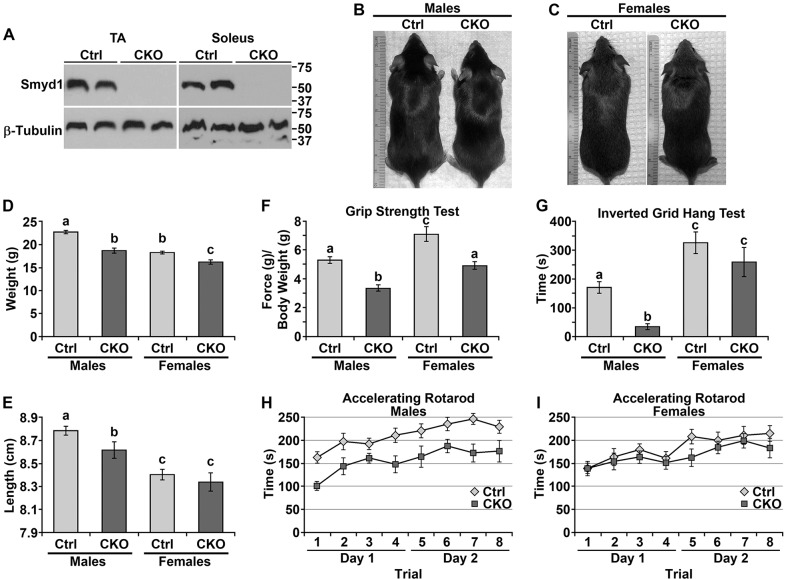
Smyd1 CKO mice are smaller with reduced strength. (A) Western blots showing the absence of SMYD1 protein in CKO muscles. (B,C) Smyd1 CKO males appeared slightly smaller than controls. Female CKOs appeared similar to controls. (D) Smyd1 CKO mice weighed less than controls. n≥17 animals/group. (E) Body length (naso-anal length) was reduced for Smyd1 CKO males, but not females. n≥17 animals/group. (F,G) Smyd1 CKO mice were weaker than controls. (F) Four-paw grip-strength tests. Data are maximum force of three pulls per animal normalized to body weight. n≥8 animals/group. (G) Inverted grid hang tests. Data are the length of time the mouse is able to hang from the grid before falling. n≥13 animals/group. (D-G) Statistics were ANOVA+post hoc tests. Significant differences (P<0.05) are denoted by the lowercase letters above each bar. (H,I) Accelerating rotarod tests for males (H) and females (I). Mice of all groups progressively increased the length of time they could run on the rotarod (two-way ANOVA, P<0.001 for both males and females). Male and female CKOs underperformed their control counterparts (two-way ANOVA; males: P<0.0001, n≥12 animals/group; females: P=0.025, n≥13 animals/group); however, the mean difference in elapsed time for male controls vs male CKOs (55.1±7.7 s) was much greater than that for female controls vs female CKOs (17.8±7.9 s). All data was obtained at 6 weeks of age. Error bars show s.e.m. Ctrl, control; CKO, conditional knockout; TA, tibialis anterior.